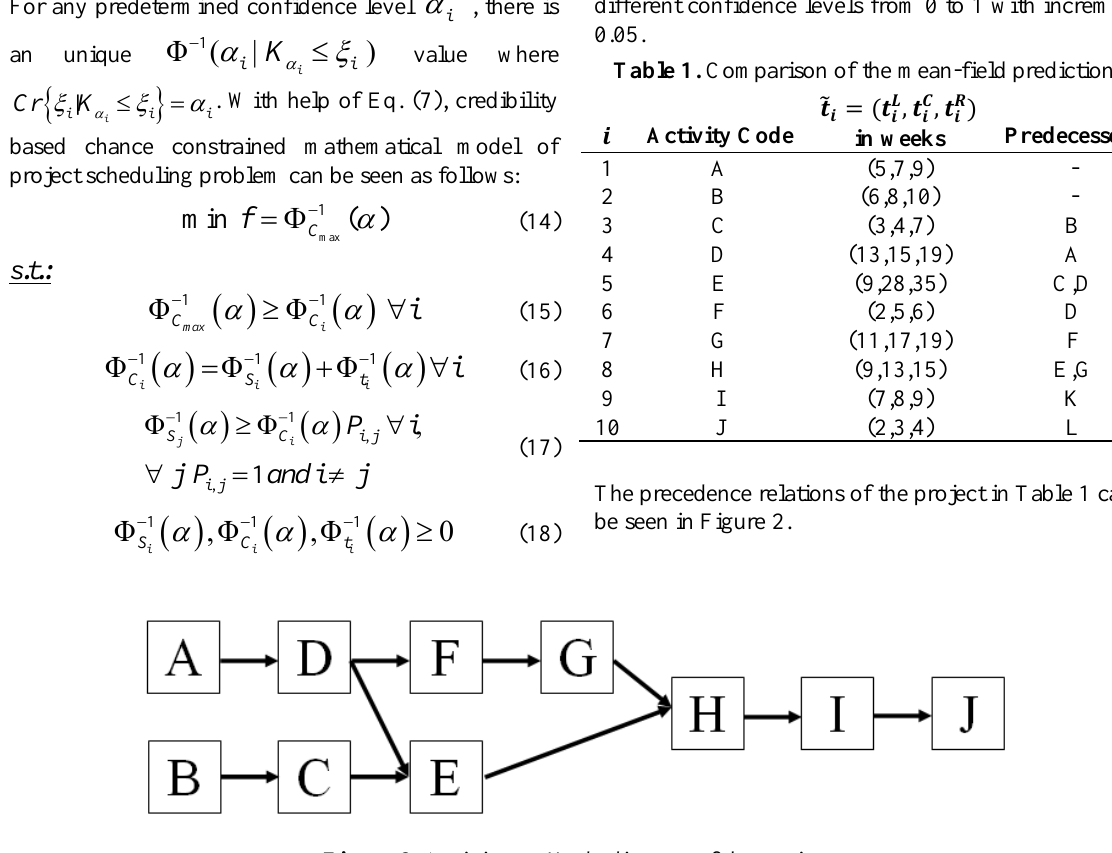
Figure 2. Activity-on-Node diagram of the